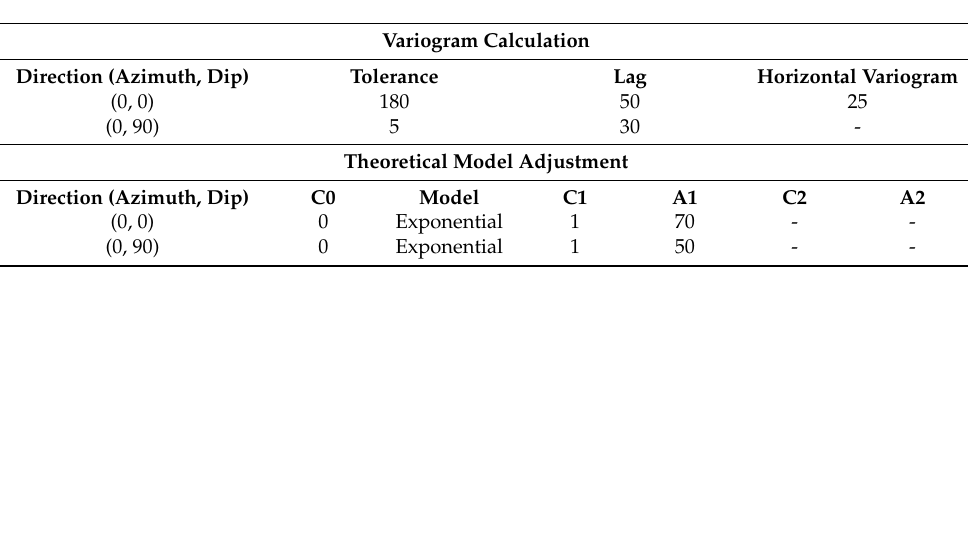
Table A9. Calculation and adjustment parameters for the borehole CL1 indicator variable variograms.